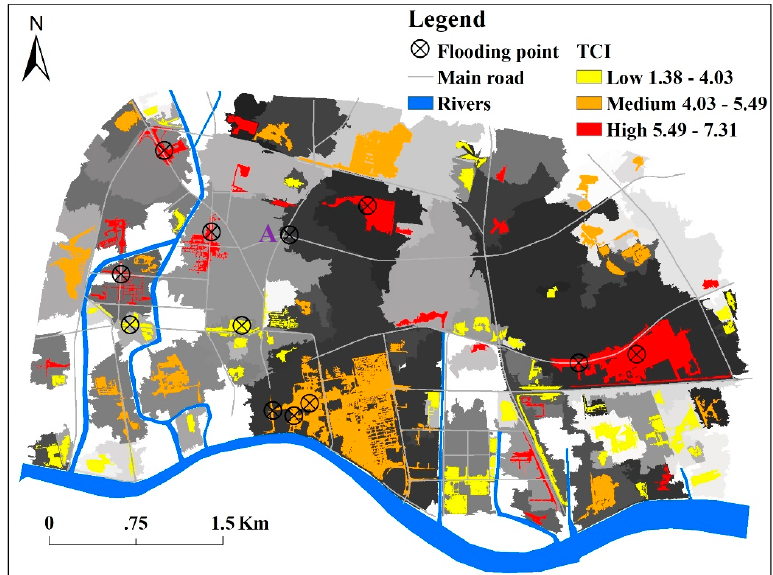
Figure 5. TCI (ln(m − 1 )) map derived from the original 0.5 m-resolution LiDAR DEM at the water depth 0.3 m. TCI values were divided into three groups: Low (yellow, TCI ≤ mean), Medium (orange, mean < TCI ≤ mean + standard deviation), and High (red, TCI > mean + standard deviation).